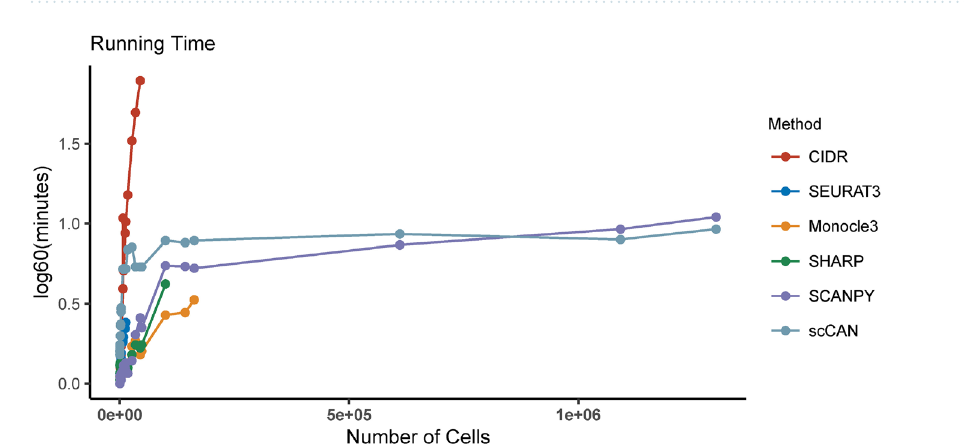
Figure 5. Running time of CIDR, SEURAT3, Monocle3, SHARP, SCANPY, and scCAN for the analysis of 28 real scRNA-seq datasets. The horizontal axis shows the number of cells while the vertical axis shows the running time in the log scale (base 60) of minutes. scCAN and SCANPY are the only two methods that can analyze datasets with more than 200,000